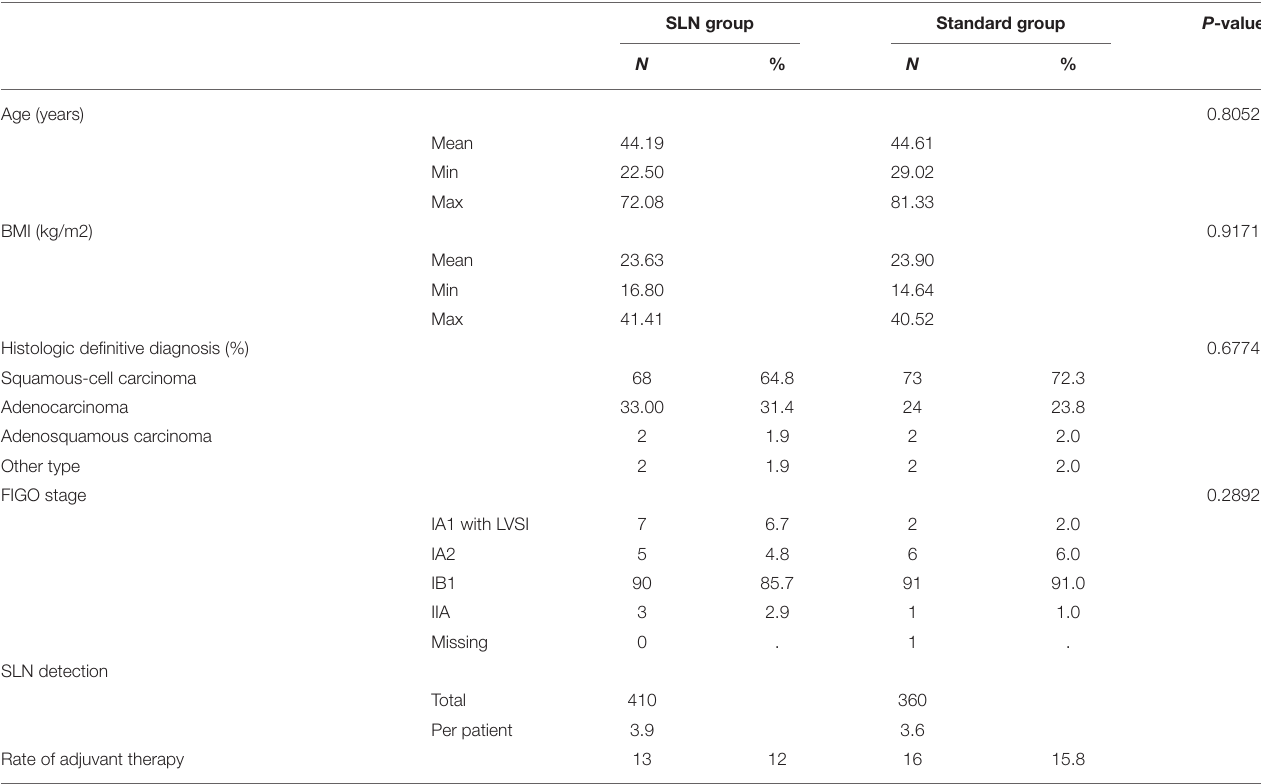
TABLE 1 | Randomized patient and tumor